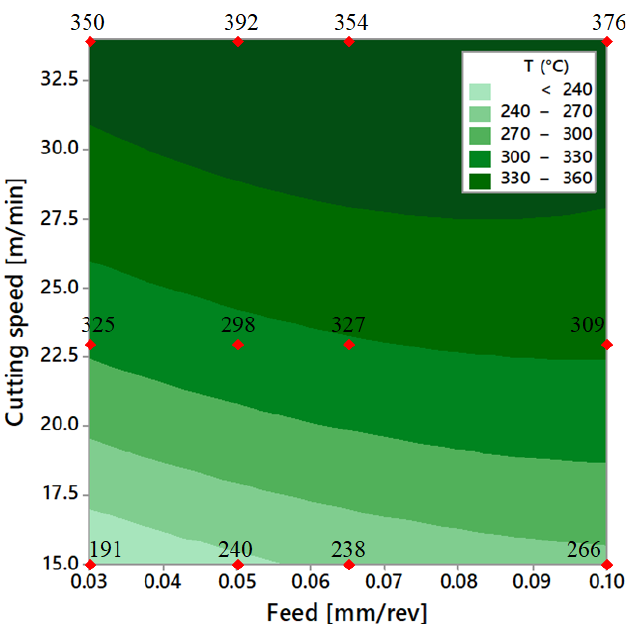
Figure 9. Contour plot of the cutting temperature against cutting speed and feed, with experimental data.